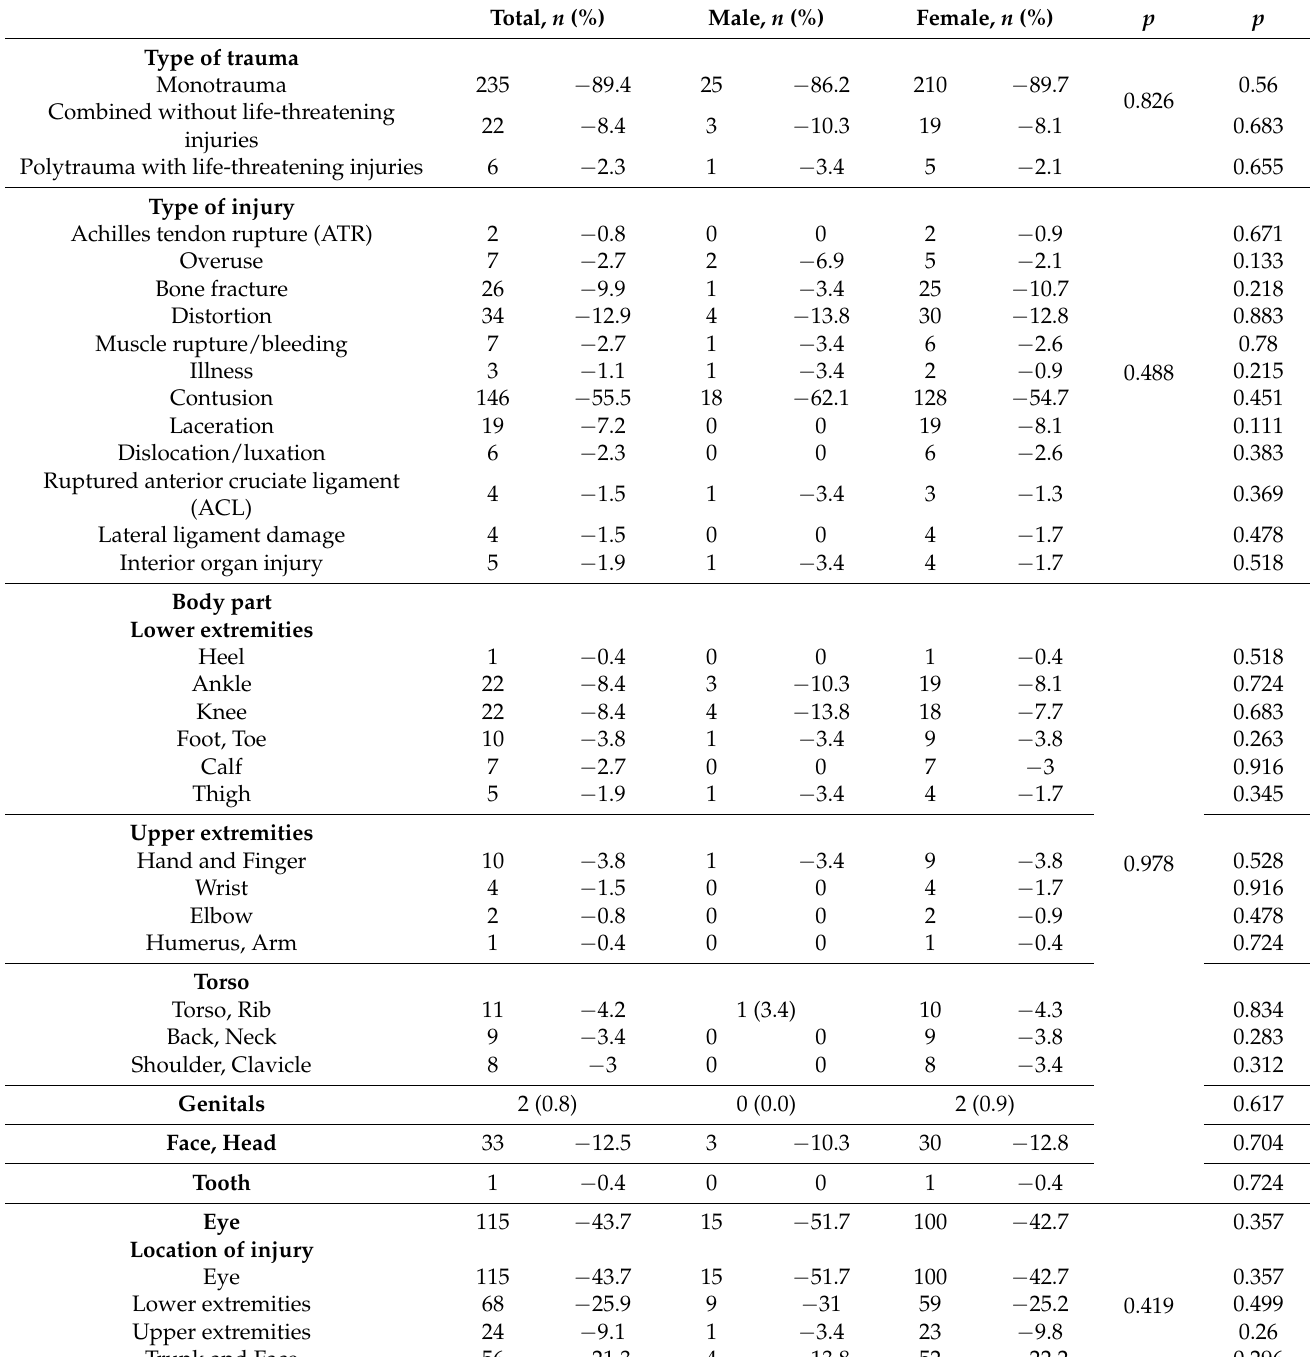
Table 2. Anatomical distribution of injuries and mechanism of injuries by frequency ( n ) according to sex